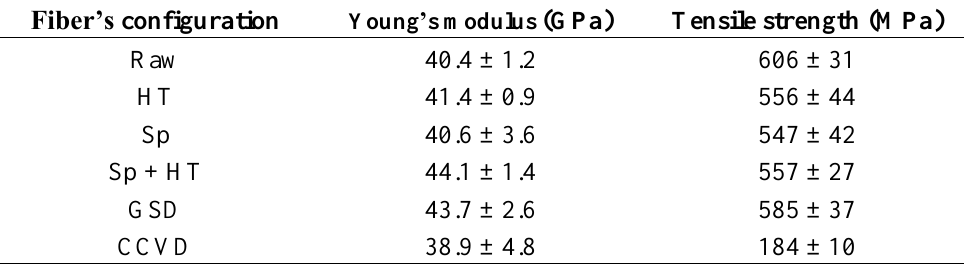
Table 2. Tensile mechanical properties for the specimens based on raw PAN-based carbon fabric (Raw), SiO sputter-coated fabric (Sp), heat-treated fabric (HT), SiO 2 then heat-treated fabric (Sp + HT) and with CNTs grown on their surfaces via GSD and